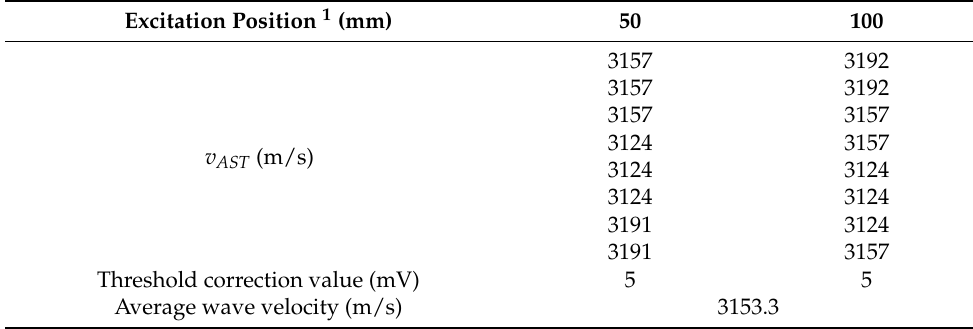
Table 3. Measurement results of the wave velocity by the AW method.